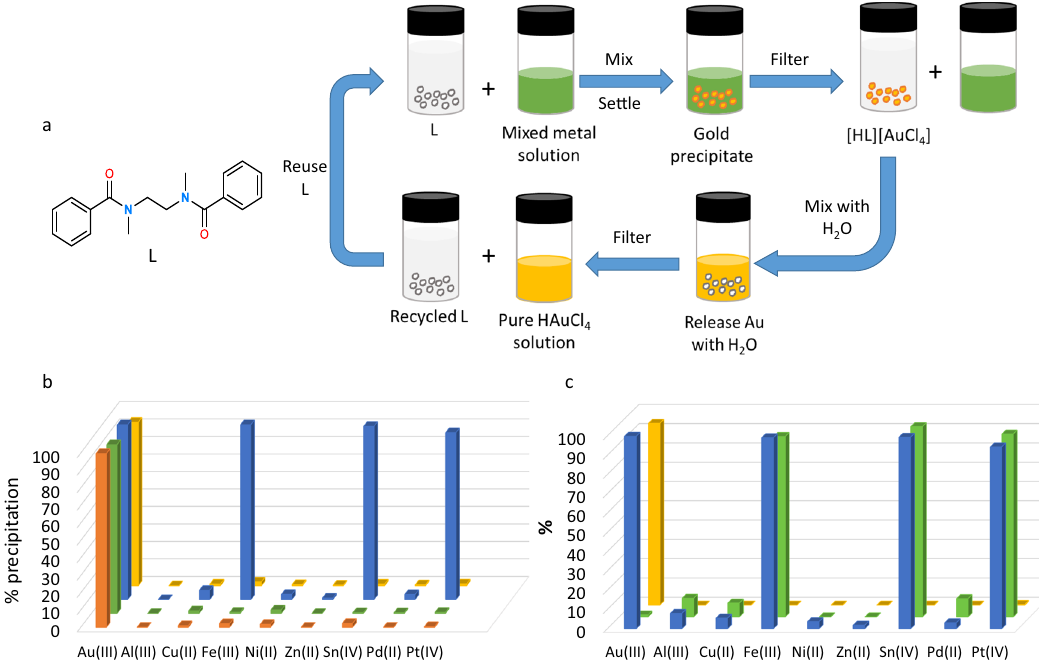
Fig. 1 Schematic of the precipitation process and its selectivity. a Chemical structure of L and schematic of the precipitation process. b Percentage metal(s) removed by precipitation from a 0.01 M mixed-metal solution in 2 M (orange and green bars) or 6 M (blue and yellow bars) HCl following the addition of either 0.2 mmol L (10-fold excess L relative to metal, orange and blue bars) or 0.02 mmol L (equimolar, green and yellow bars). c Selective metal precipitation and stripping sequence. Blue bars: Percentage metal removed by precipitation from a 0.01 M mixed-metal solution in 6 M HCl. Green bars: percentage of metal stripped from the precipitate by a 2 M HCl wash. Yellow bars: percentage of metal stripped from the precipitate after a subsequent wash with deionised water. Experiments carried out in